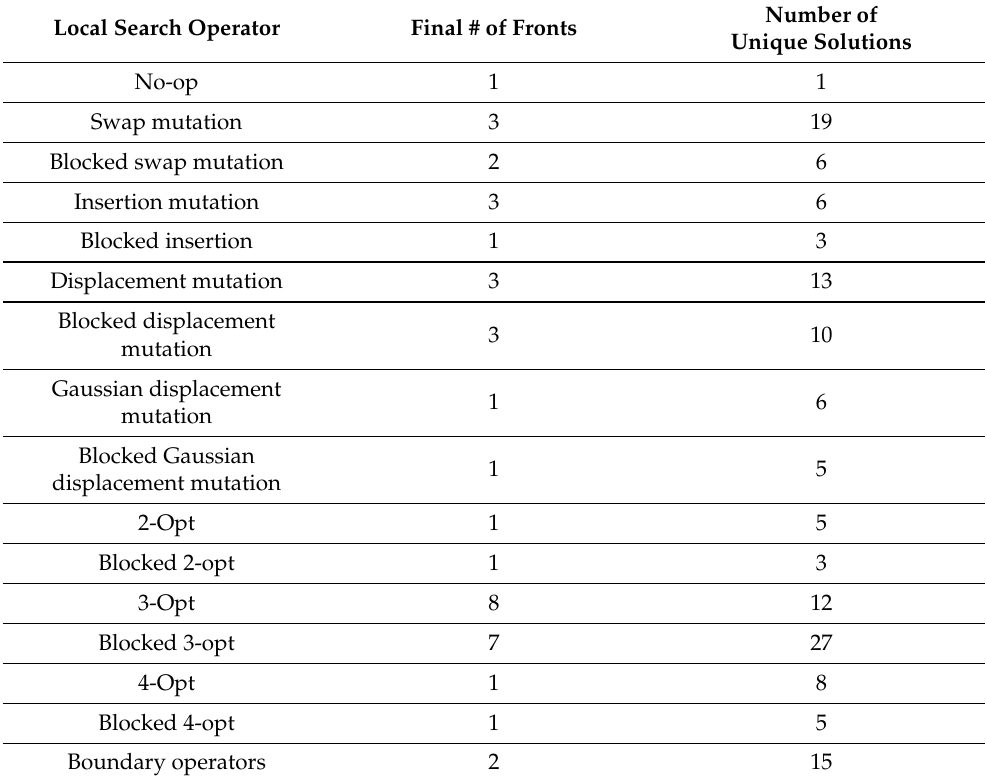
Table 5. Local search operators effects on diversity of bar-n100-1